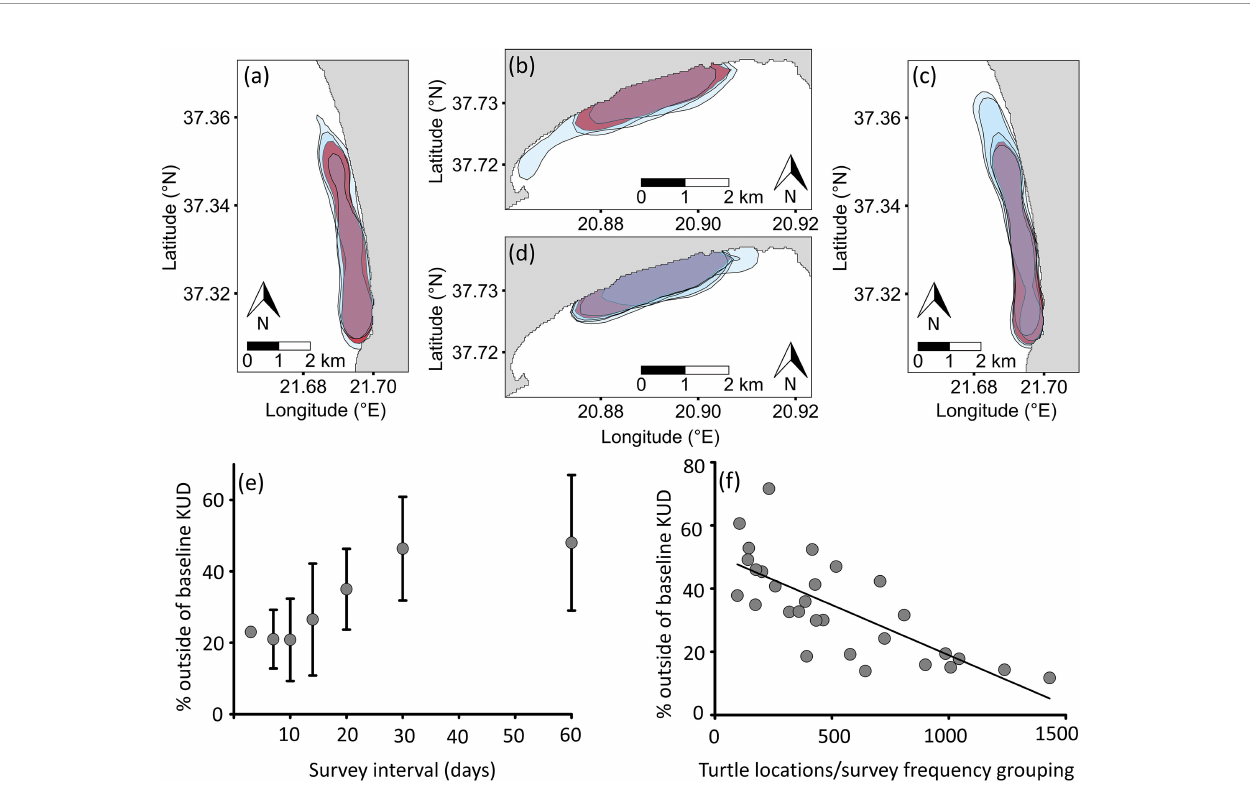
FIGURE 2 | Variability in 50% Kernel Utilization Distribution (KUD) of loggerhead sea turtles ( Caretta caretta ) during the breeding period (May-June) with respect to (A, B) year and baseline and (C, D) sampling frequency within years and baseline at Kyparissiakos (A, C) and Zakynthos (B, D) . Blue shading represents 50% KUDs of the three survey years (900-1470 locations Kyparissiakos; 815-1431 locations Zakynthos); red shading represents the combined 50% KUD of the three years (used as baseline; 3608 locations Kyparissiakos; 3232 locations Zakynthos). (C, D) Blue shading represents 50% KUDs of the tested survey frequencies (E) , and red shading represents baseline. (E) Within year sampling frequency impacted the representativeness of KUDs, along with (F) the number of turtle locations recorded across surveys (F 1,28 = 75, P <